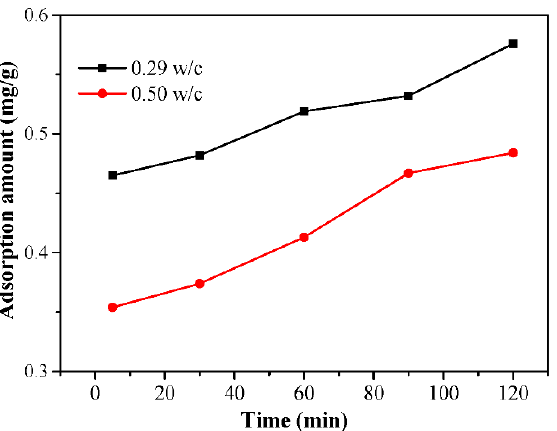
Figure 13. Adsorption amount evolution of the PCEs in the two w/c cement pastes over the elapsed time.